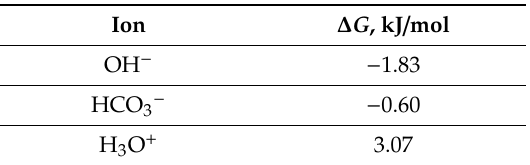
Figure 4. The change of the Gibbs free energy during the adsorption of OH − , H 3 O + , and HCO 3 − ions on the air / water interface. Table 6. Values of change of the free Gibbs energy of adsorption of the OH − , HCO 3 − , and H 3 O + ions on the air / water